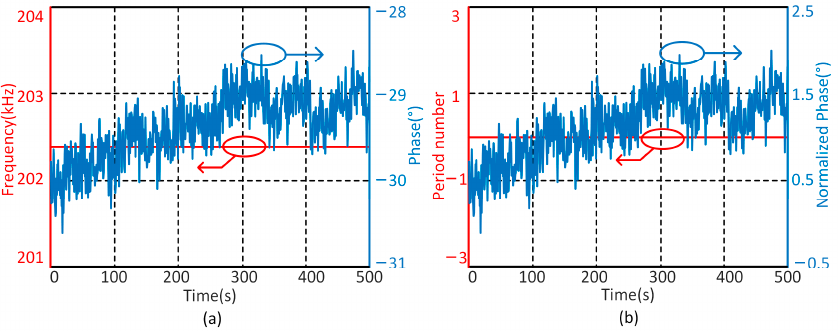
Figure 4. Measurement results when FTD is fi xed . ( a ) measured peak frequencies (red) and peak phases (blue); ( b ) the number of periods (red) and normalized phases (blue).